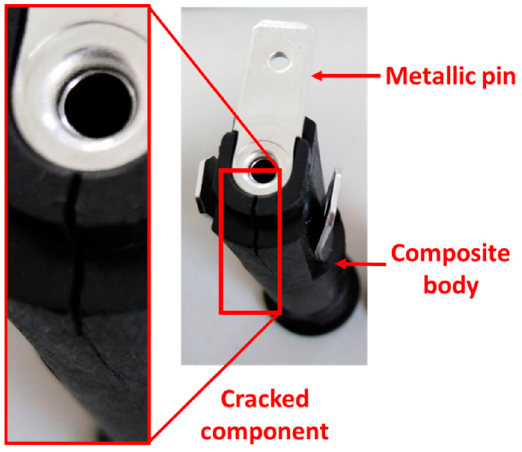
Figure 1. Crack in the considered electrical component.